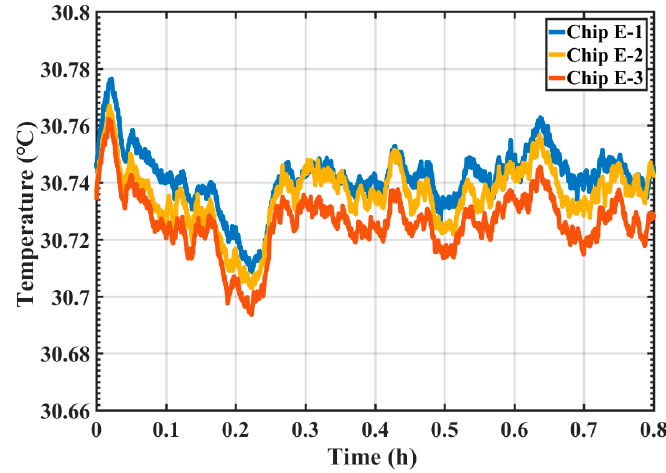
Figure 7. Consistency test results between Chip E-1, 2, 3.